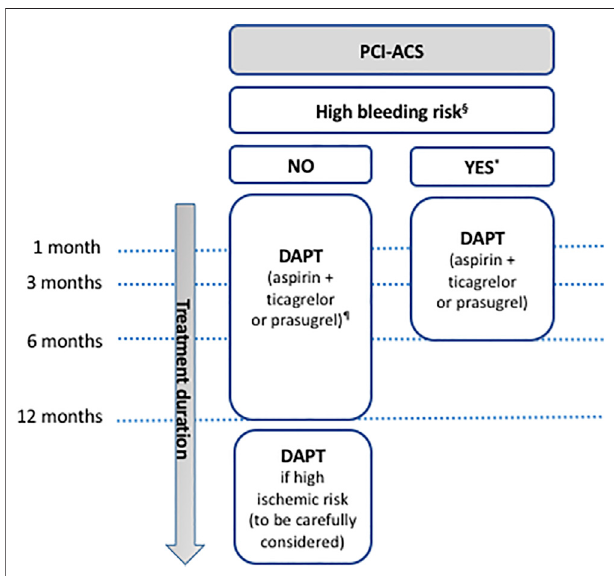
FIGURE 2 | Antiplatelet therapy in ACS patients undergoing PCI. § in case of history of prior bleeding, oral anticoagulant therapy, female sex, advanced age, low body weight, chronic kidney disease, diabetes mellitus, anemia, chronic steroid or nonsteroidal anti-in fl ammatory drugs (NSAID) therapy (American guidelines); in case of need for oral anticoagulant drugs in addition to DAPT, advanced age (older than 75 years), frailty, anemia with hemoglobin < 110 g/L, chronic renal failure (creatinine clearance < 40 ml/min), low body weight ( < 60 kg), hospitalization for bleeding within past year, previous stroke/intracranial bleed or regular need for NSAIDs or prednisone (Canadian guidelines); having PREdicting bleeding Complications In patients undergoing Stent implantation and subsEquent Dual Anti Platelet Therapy (PRECISE-DAPT) score ≥ 25 or meeting the Academic Research Consortium for High Bleeding Risk (ARC-HBR) criteria (European guidelines); having PRECISE-DAPTscore ≥ 25orDAPTscore < 2(givenasexamplessincelimited data are available to evaluate the applicability of these scoring systems to the Japanese population; Japanese guidelines). * except for the Canadian guidelines that do not propose to shorten duration of DAPT in patients at high bleeding risk. ¶ except for the Japanese guidelines that recommend aspirin + clopidogrel or prasugrel. DAPT: dual antiplatelet therapy; PCI: percutaneous coronary intervention; ACS: acute coronary syndrome.